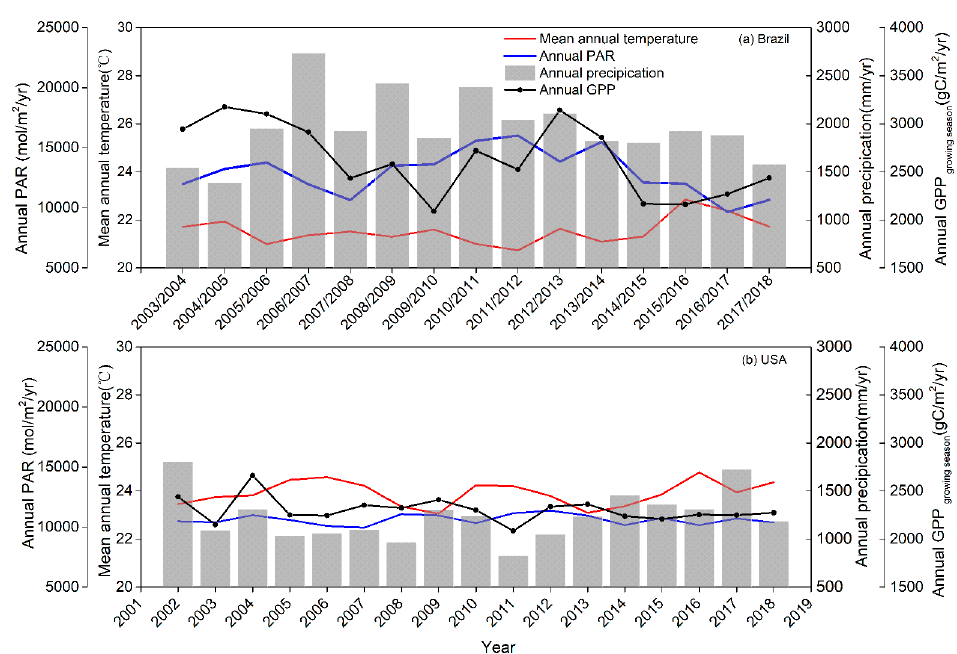
Figure 9. Interannual variation in the annual mean air temperature ( o C), annual precipitation (mm yr − 1 ), annual PAR (mol m − 2 yr − 1 ), and annual GPP as predicted by the VPM model with the NCEP climate data (GPP VPM-NCEP , g C m − 2 yr − 1 ) during the plant growing season at two sugarcane plantation sites. ( a ) Brazil site; ( b ) Louisiana, USA site.